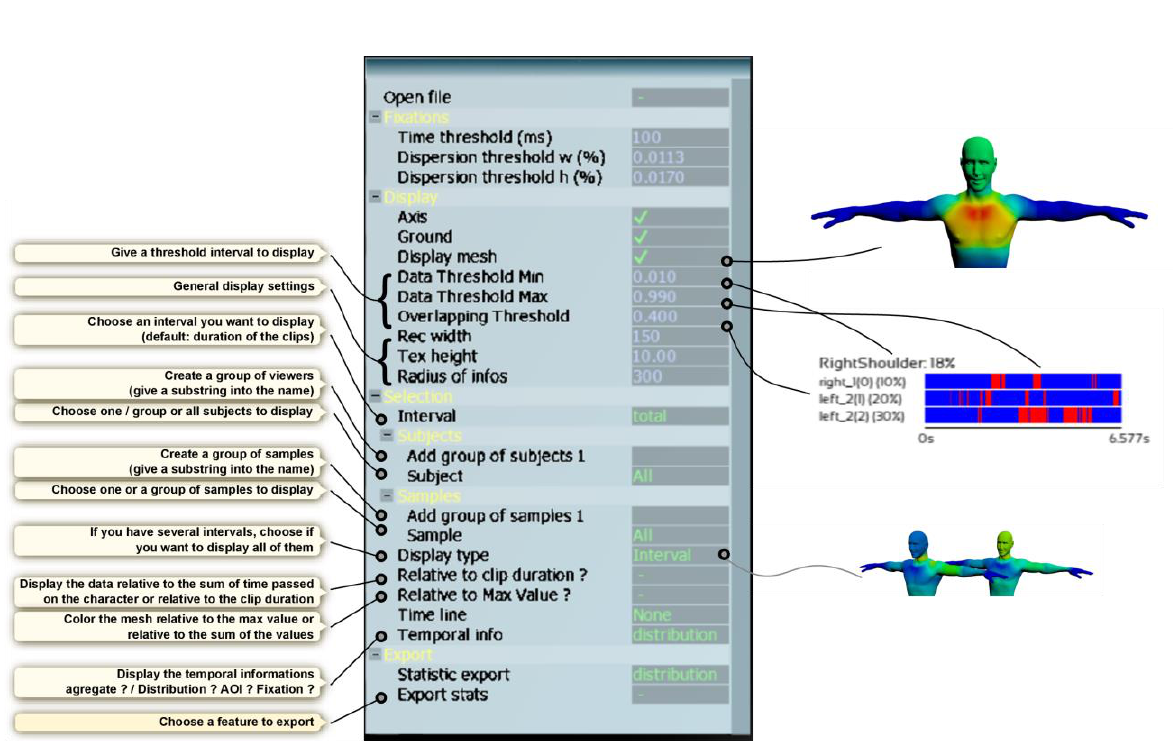
Figure 8. Graphical User Interface: Overview of the